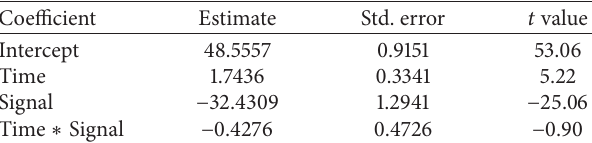
Table 8: Correlation of fixed effects.